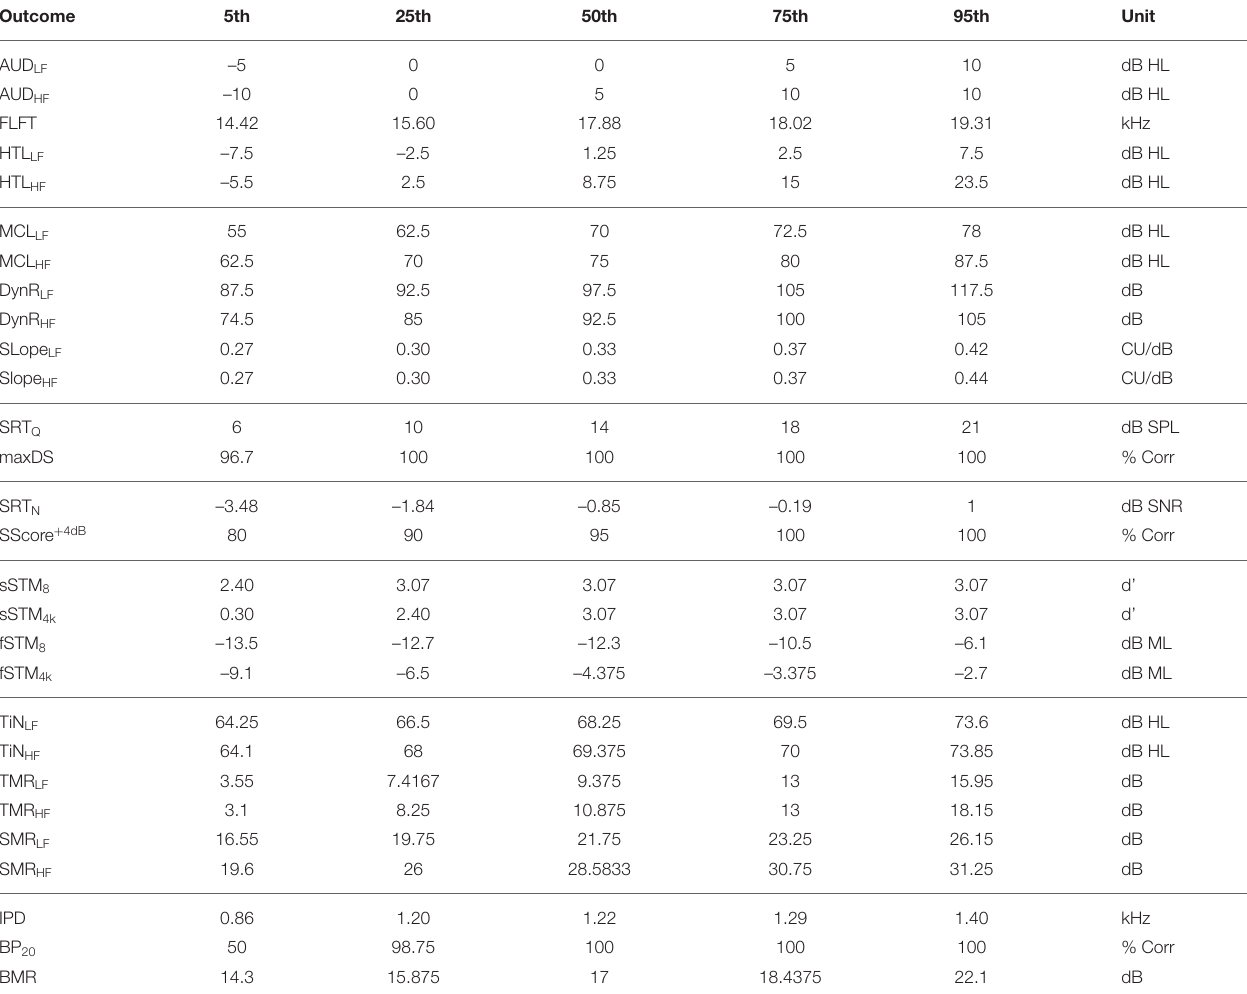
TABLE 2 | Reference data of the young normal-hearing group.